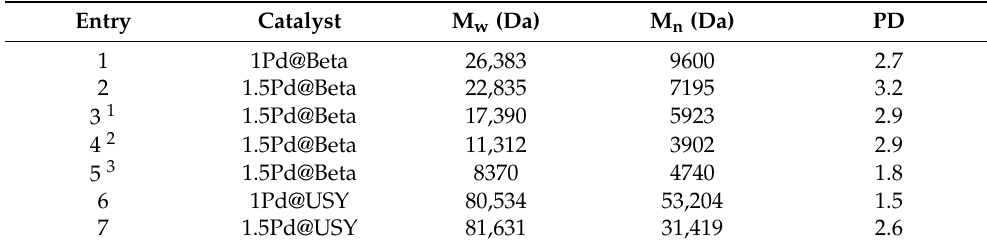
Table 4. Molar masses of humins recovered from the hydrodeoxygenation